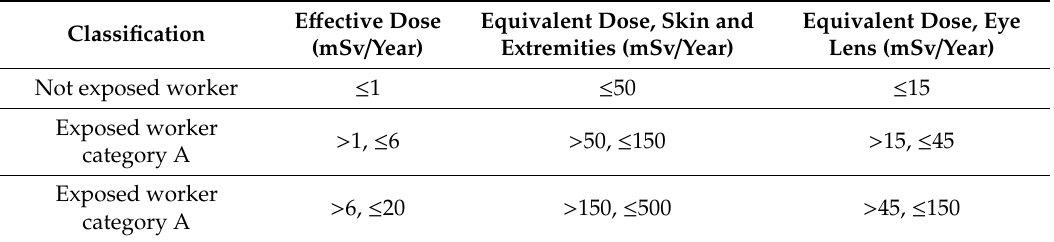
Table 1. Dose limit for each exposure class according to the Italian